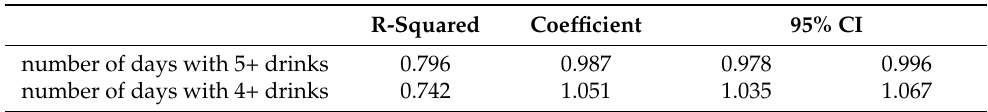
Table 2. Ability of the model * to predict number of days when an individual consumes 5+ drinks (both sex) or 4+ drinks (female only) in the past 30 days. R-Squared Coefficient 95% CI number of days with 5+ drinks